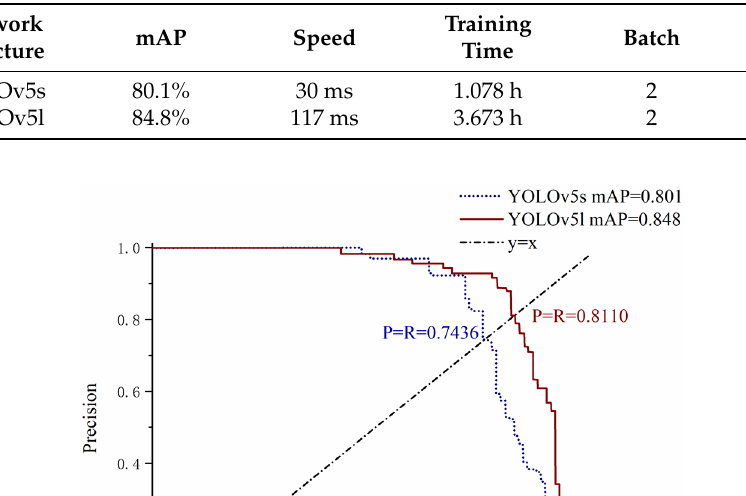
Table 5. Detection results of wake in the measured SAR images.